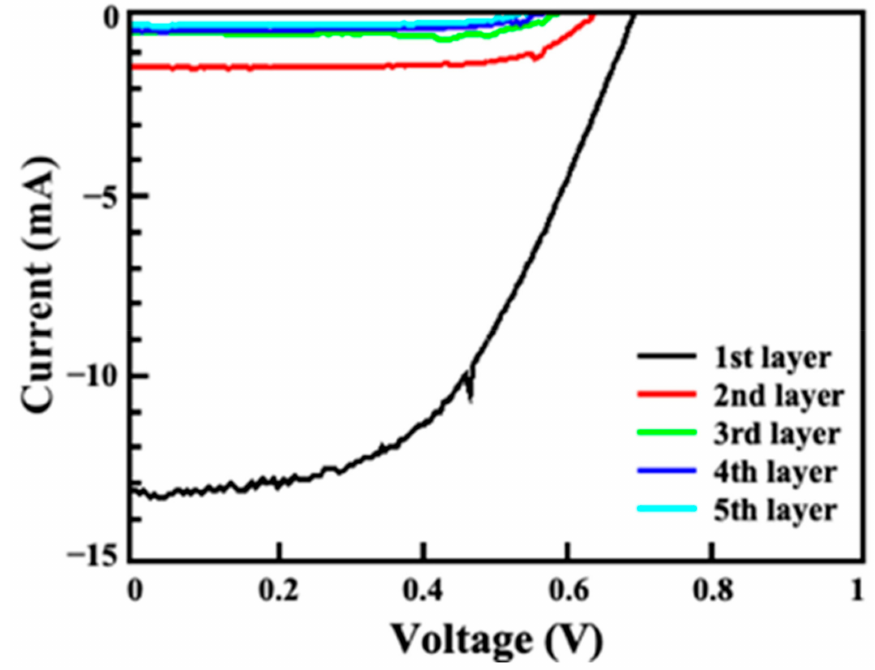
Figure 12. I–V curves of different layers of N719-DSSCs. Table 1. The performance parameters of the N719 DSSCs under 100 mW/cm 2 light irradiation. Voc Isc P Max Light Density Efficiency F.F. (V) (mA) (mW) (W/cm 2 )